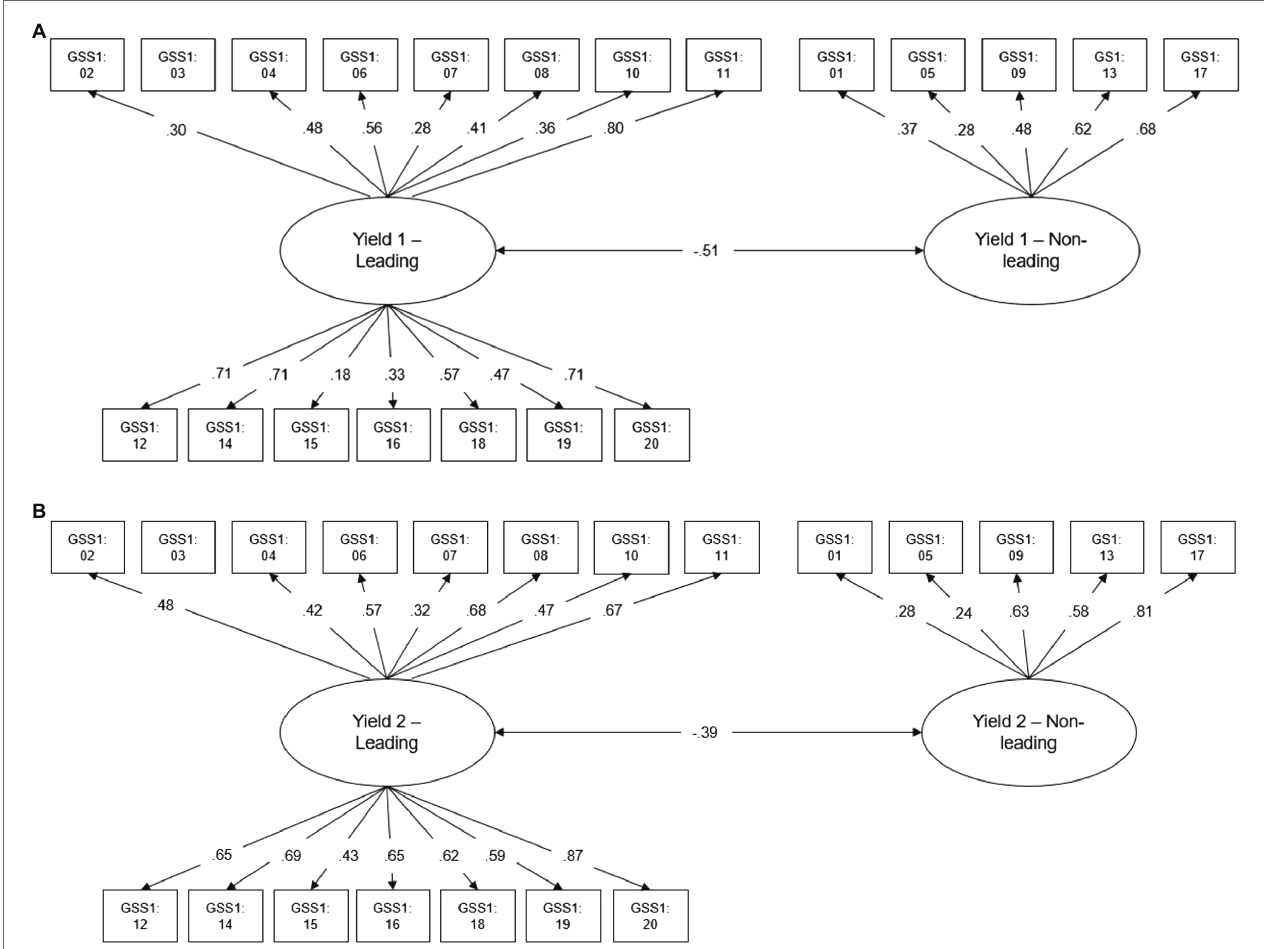
FIGURE 1 | Measurement model (completely standardized solution) for Yield 1 items (A) and Yield 2 items (B) of a German online GSS